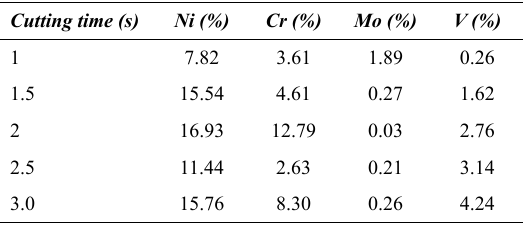
Table 4. EDS analysis of worn tools for prolonged